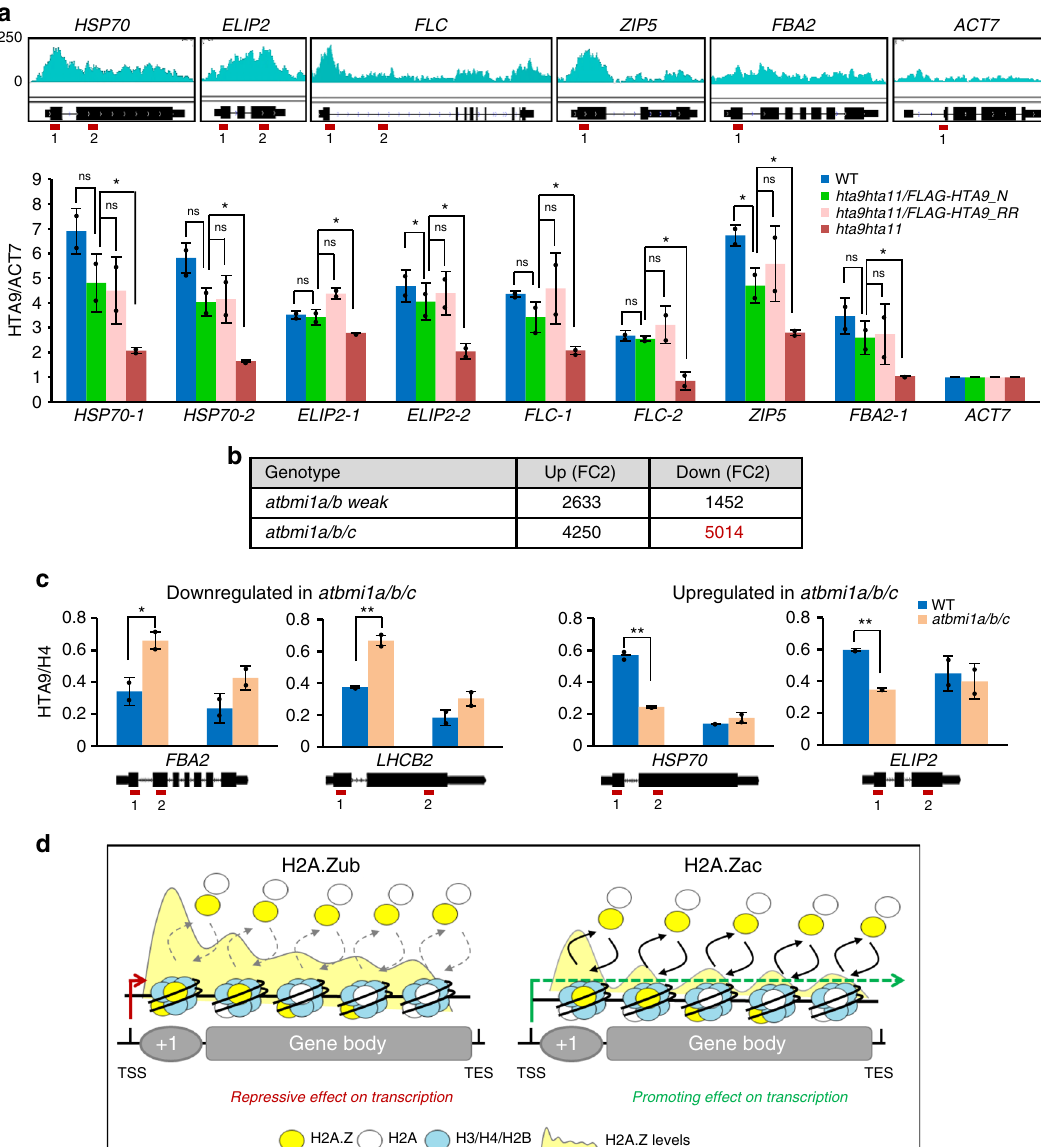
Fig. 6 H2A.Zub more than H2A.Z incorporation is required for repression. a HTA9 levels analyzed by chromatin immunoprecipitation – quantitative polymerase chain reaction (ChIP-qPCR) at different genes in wild-type (WT), hta9hta11/FLAG-HTA9_N , hta9hta11/FLAG-HTA9_RR and hta9hta11 plants at 7 days after germination (DAG). Browser views of H2A.Z levels in WT at the selected genes and schematic representation of each gene with red lines indicating the position of ampli fi ed regions are shown. HTA9 levels were normalized to ACT7 . Error bars indicate standard deviation of n = 2 biological replicates. Data points are indicated in the bar charts. Signi fi cant differences as determined by Student ’ s t test are indicated (* P < 0.05; ns, not signi fi cant). b Number of genes upregulated and downregulated determined by RNA-seq in atbmi1a/b weak and atbmi1a/b/c compared to WT seedlings at 7 DAG. Downregulated genes in atbmi1a/b/c are highlighted in red. c HTA9 levels analyzed by ChIP-qPCR at two downregulated and two upregulated genes in atbmi1a/b/c (Supplementary Fig. 6b, c). A schematic representation of the genes is included indicating the position of ampli fi ed regions (red lines). HTA9 levels were normalized to H4 levels. Error bars indicate standard deviation of n = 2 biological replicates. Data points are indicated in the bar charts. Signi fi cant differences as determined by Student ’ s t test are indicated (* P < 0.05; ** P < 0.01). d Proposed model for H2A.Z-mediated gene regulation in which monoubiquitination of H2A.Z is required for transcriptional repression (left) and acetylation of H2A.Z for transcriptional activation, while H2A.Z levels along the genes are consequence of the transcriptional activity, where transcriptional repression leads to accumulation of H2A.Z (left) and active transcription to decreased levels of H2A.Z (right). Source data of Fig. 6a, c are provided as a Source Data fi